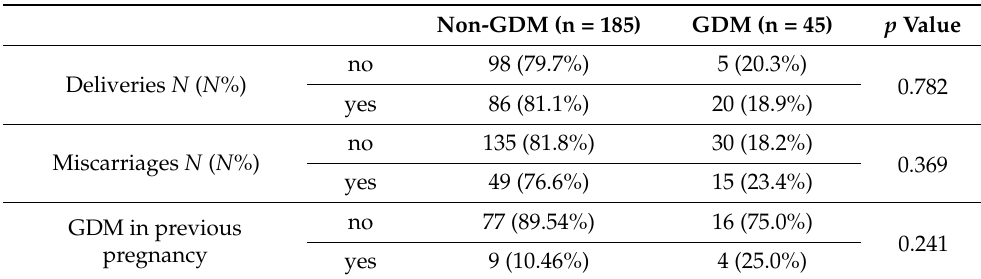
Table 3. Previous obstetric history.